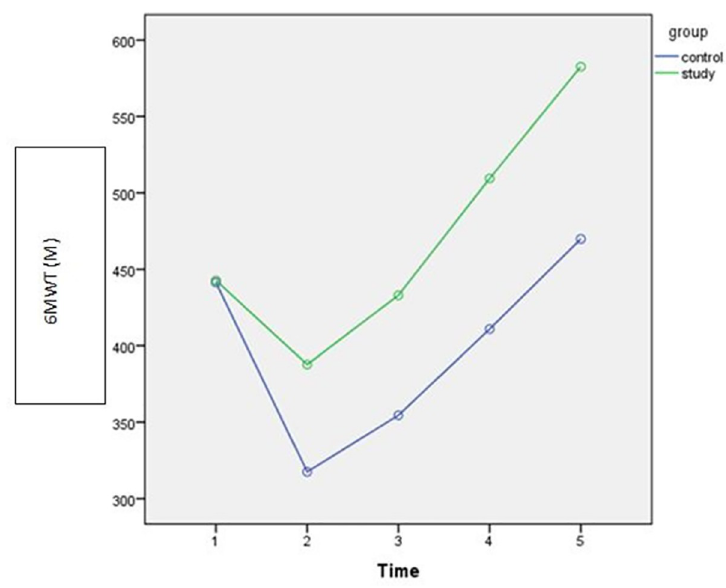
Fig 6. Estimated marginal means of functional capacity measured by (6MWT) [1: Pre-operative; 2: Discharge; 3: 4 th POW; 4: 8 th POW; 5: Follow-up].